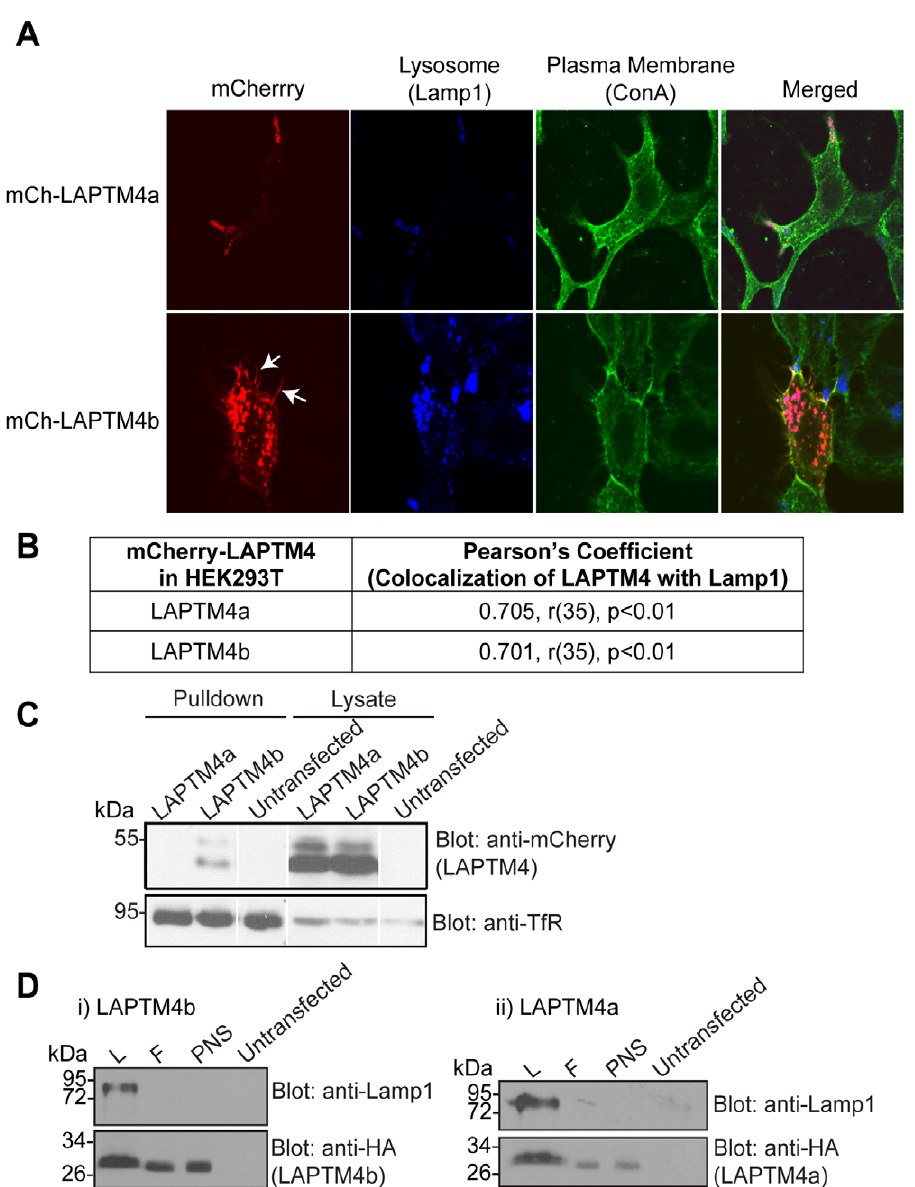
Figure 2. Both LAPTM4 proteins localize to lysosomes, but LAPTM4b is uniquely present also at the cell surface. (A) 24 hrs post transfection the plasma membrane (ConA, green) of Hek293T cells expressing mCh-LAPTM4a (red, top) or mCh-LAPTM4b (red, bottom) was stained, cells were fixed and incubated with anti-Lamp1 antibodies (blue). White arrows indicate mCh-LAPTM4b in hair-like protrusions. Cells were imaged using LSM510 and subcellular localization was assessed using Volocity 5.4.1. (B) Colocalization of LAPTM4s with the lysosomal marker Lamp1 was expressed in terms of the Pearson’s correlation coefficient. Degrees of freedom are noted as (r), level of significance as (p). n=37 for LAPTM4a and LAPTM4b. (C) Untransfected or transfected (mCh-LAPTM4a-WT or mCh-LAPTM4b-WT) Hek293T cells were subjected to cell surface biotinylation, lysis, pulldown with streptavidin agarose beads and separation on SDS-PAGE. Cell surface biotinylation of the Transferrin receptor (TfR) was used as a positive control. (D) Biochemical evidence for the presence of LAPTM4 proteins in lysosomes: Lysosomal fraction from Hek293T cells overexpressing HA-LAPTM4a or b were isolated as described in the Materials and Methods section. Post nuclear supernatant (PNS) was loaded on a magnetic column, the flowthrough (F) was collected and upon removal of the column from the magnet the lysosomal fraction (L) was eluted. Western blotting shows significant enrichment of endogenous Lamp1 in the L fraction, as well as the presence of LAPTM4a or b.